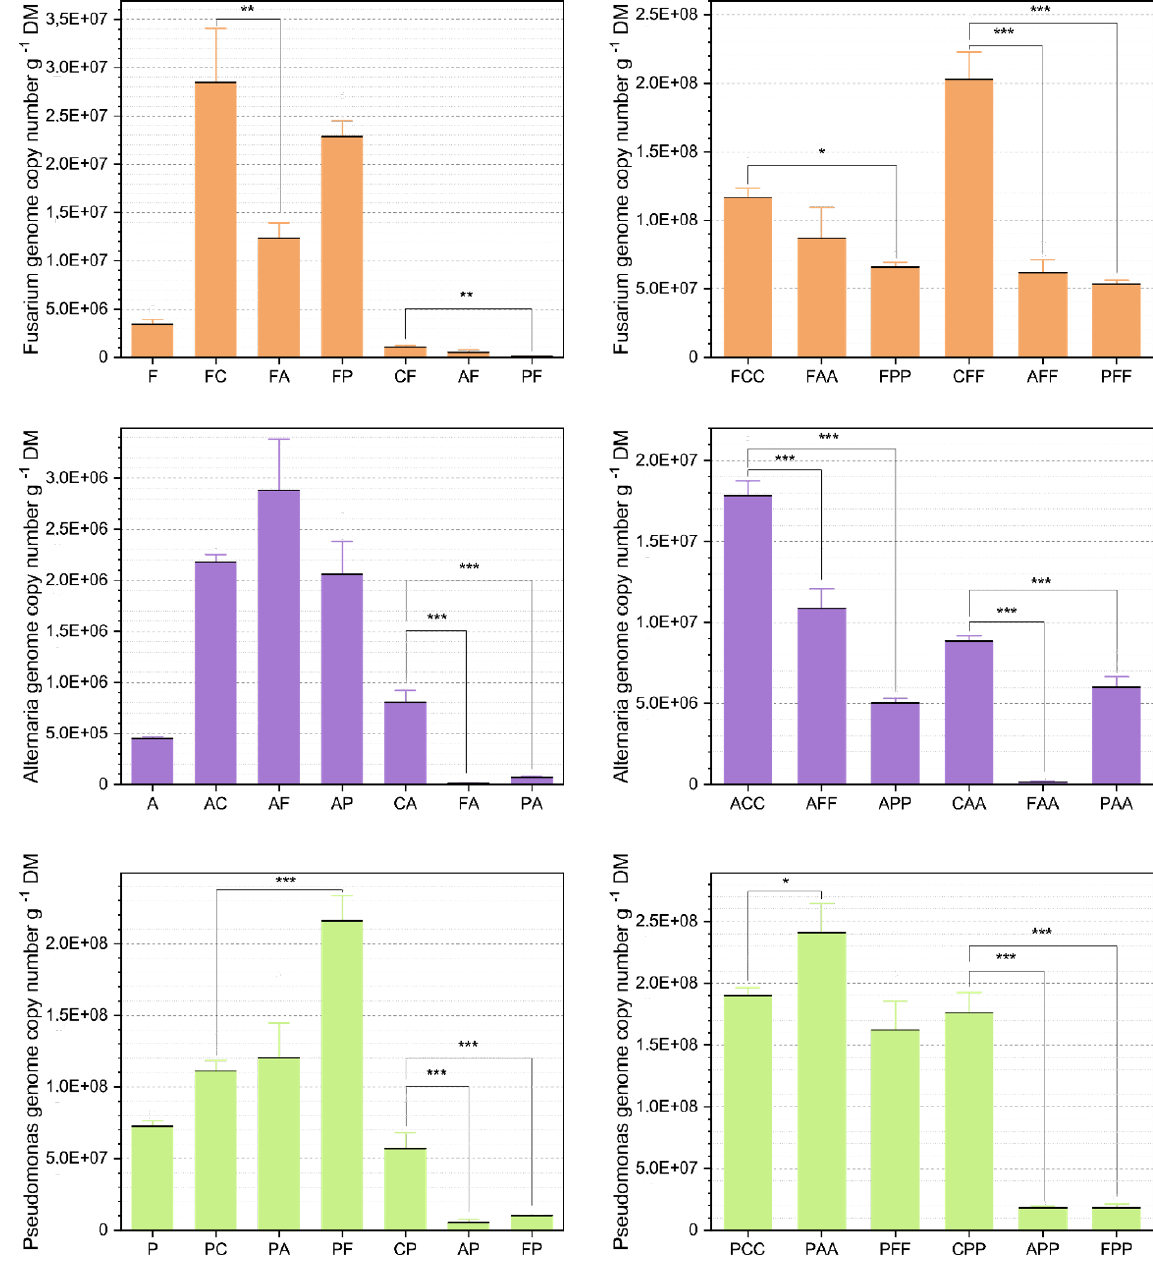
Figure 3. Fungal and bacterial growth were influenced by temporally shifted co-inoculation. Samples were taken after one (one capital letter), two (two capital letters), and three (three capital letters) weeks; with C=control with 1/4 sterile Ringer’s solution; A = Alternaria tenuissima At 625, F = Fusarium graminearum Fg 23, P = Pseudomonas simiae Ps 9 inoculation. The mean values are plotted with their standard errors of the mean. Asterisk brackets indicate significant differences (* p < 0.1, ** p < 0.05, *** p <